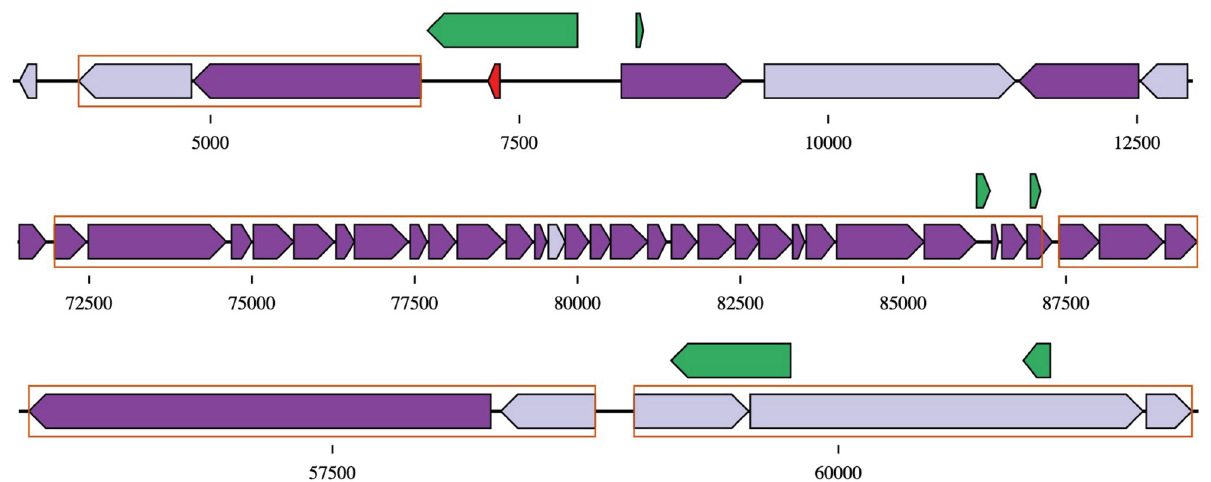
Fig 5. Selected cases of rescued ORFs using metaproteomic data in P. vulgatus genome. The three blocks of arrows represent genes predicted from three regions in this genome: from the top to the bottom are contigs with IDs of NZ_QRPW01000017.1, NZ_QRPW01000005.1, and NZ_QRPW01000002.1, respectively. Genes predicted by FGS and/or Prokka are shown as purple arrows around the central lines, each representing a segment of the genome: dark purple and light purple are for genes with spectral support in at least two metaproteomic datasets, or only one metaproteomic dataset, respectively. The red small arrow represents a tRNA gene predicted by Prokka. Rescued ORFs are shown as green arrows above the lines. Genes in the same putative operon structure are surrounded in orange squares.